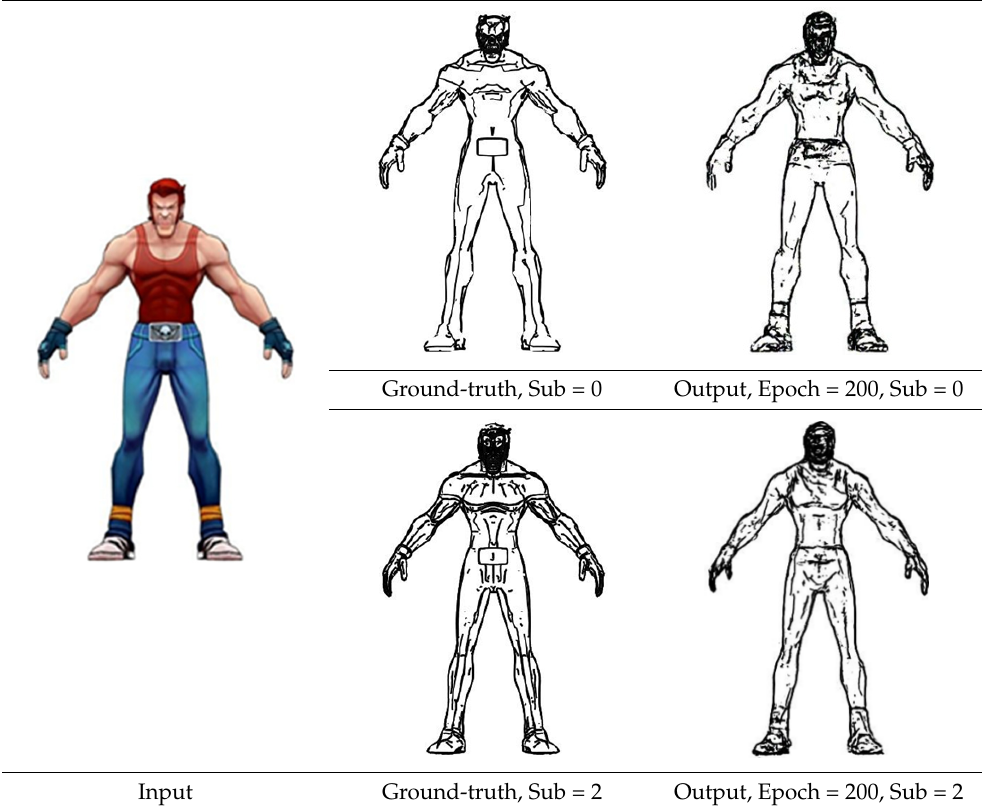
Table 2. Output according to the number of subdivision surfaces performed.